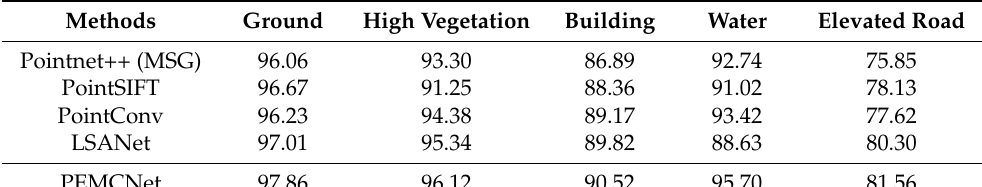
Table 2. Classification accuracy of each class of different networks on US3D dataset in terms of IoU (%).